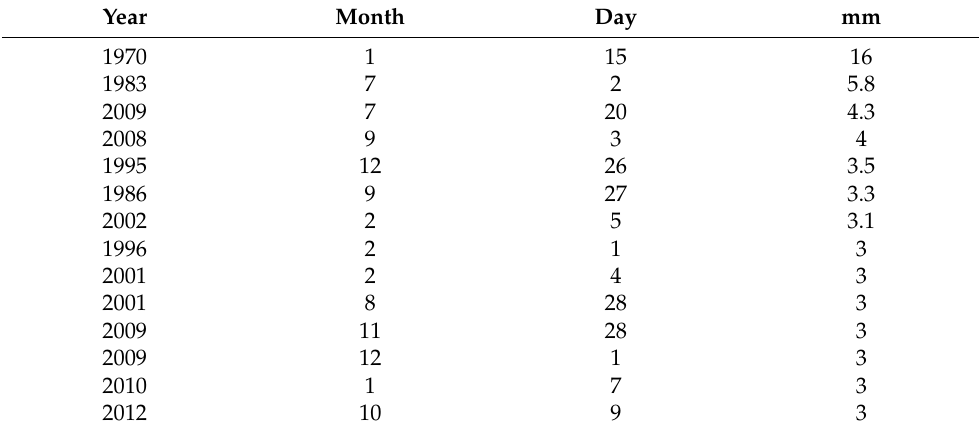
Table 3. Date of occurrence of the daily extreme precipitations in ML (above the 99th percentile), HU